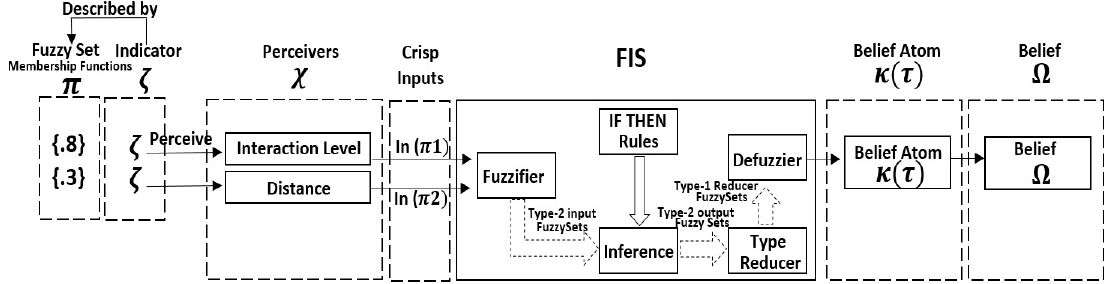
Figure 7. Fuzzy perception process. The figure shows the fuzzy perception process. This process